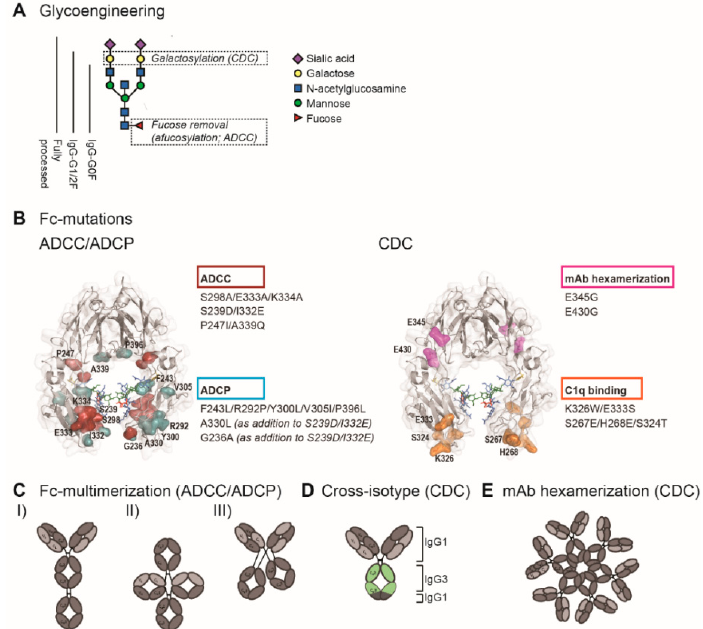
Figure 2. Fc engineering strategies to enhance Fc-e ff ector functions. ( A ) The biantennary complex glycan structure of the most frequent variants for the N-glycan of therapeutic IgG (G0F, G1F, G2F, and fully processed). Glycoengineering strategies focus on galactosylation for enhanced CDC and afucosylation for enhanced ADCC. ( B ) ADCC / ADCP (left) and CDC (right) enhancing point mutations depicted in the crystal structure of the Fc region (PDB:3DO3). The ADCC-enhancing mutations S298A / E333A / K334A, S239D / I3332E, and P247I / A339Q are depicted in magenta; the ADCP-enhancing mutations F234L / R292P / Y300L / V305I / P396L, A330L, and G236A are shown in blue. A330L and G236A were added to the ADCC-enhancing mutations S239D / I332E to decrease the mutation-related increase in a ffi nity to the inhibitory receptor Fc γ RIIb. The CDC-enhancing mutations E345G and E430G, which induce Fc / Fc interactions and subsequent mAb hexamerization (see E ), are shown in orange and K326W / E333S and S267E / H268E / S324T, which enhance C1q binding a ffi nity, are shown in pink. ( C ) Schematic representation of three Fc multimerization strategies which are aimed to enhance ADCC and ADCP. ( D ) Cross-isotype antibody generated by replacing the C H 2 and part of the C H 3 domains of an IgG1 antibody with the corresponding regions of an IgG3 antibody, to increase the CDC response. ( E ) Schematic representation of mAb hexamerization which facilitates C1q binding and enhances CDC, and can occur upon antigen binding by IgG1 antibodies naturally or when harboring the E345G or E430g